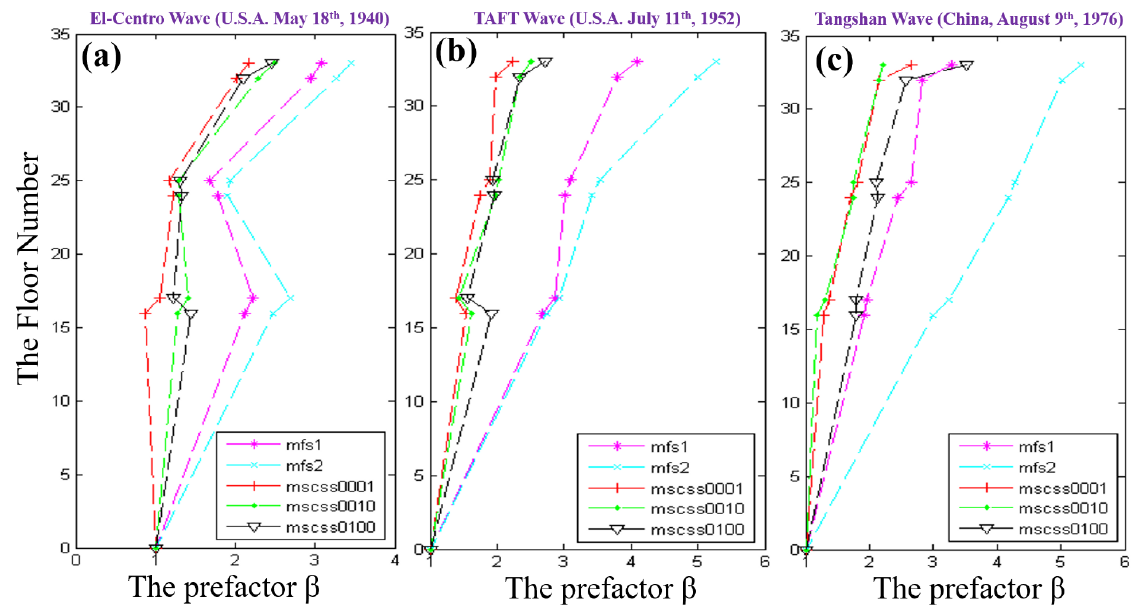
Figure 4. The acceleration response along the mega-sub structural floor number to various severe earthquake waves: ( a ) the El Centro; ( b ) the TAFT; ( c ) the Tangshan.